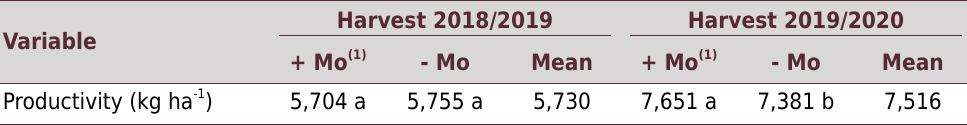
Table 2. Conilon coffee productivity in response to molybdenum fertilization